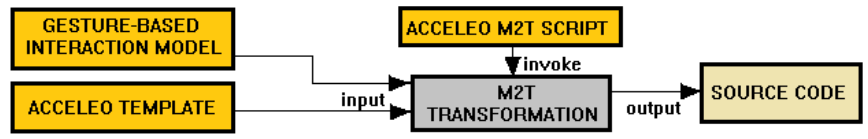
Figure 5. The code generation